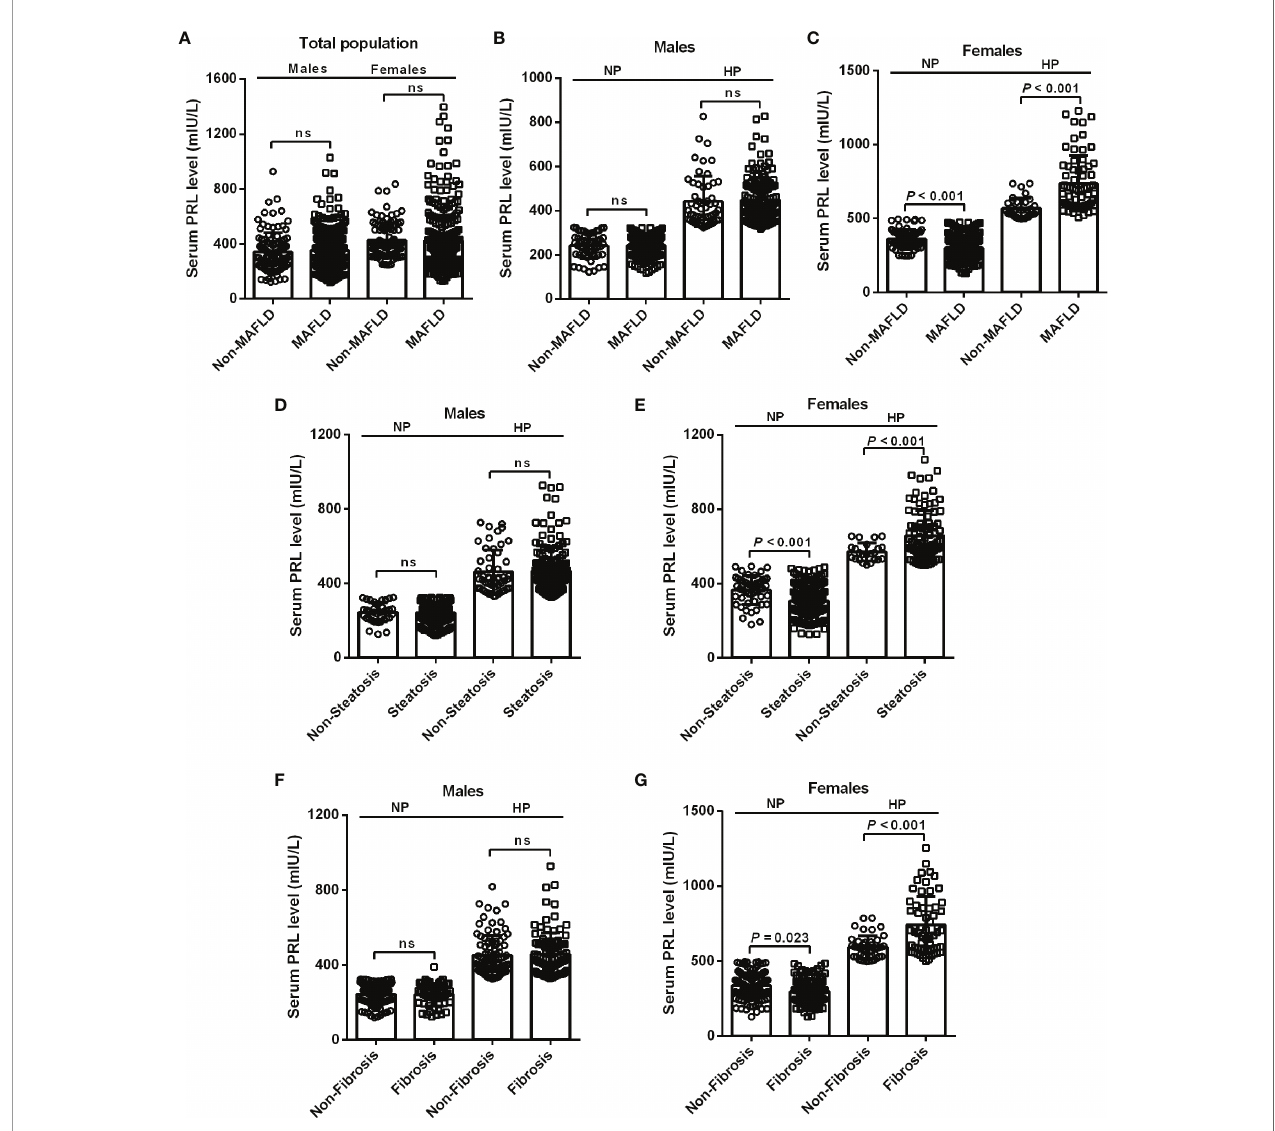
FIGURE 2 | Levels of serum PRL among diabetic patients with or without MAFLD, steatosis, and fi brosis strati fi ed by PRL levels and gender. (A) The serum PRL levels did not change signi fi cantly between the MAFLD and non-MAFLD groups in the total population. (B, C) Among females, patients with MAFLD had signi fi cantly decreased serum PRL levels within the NP group but increased serum PRL levels within the HP group compared with their counterparts, which was not observed in males. (E, G) Female patients with steatosis or fi brosis had signi fi cantly lower serum PRL levels within the NP group but higher serum PRL levels within the HP group compared with their counterparts. (D, F) No signi fi cant differences were observed in serum PRL levels among males with steatosis or fi brosis compared with their counterparts neither in the NP group nor in the HP group. The high PRL (HP) group was de fi ned as serum PRL ≥ 324 mIU/L in males or ≥ 496 mIU/L in females. The normal PRL (NP) group was de fi ned as serum PRL <324 mIU/L in males or <496 mIU/L in females. PRL, prolactin. P -values <0.05 were accepted as statistically signi fi cant. ns, non-signi fi